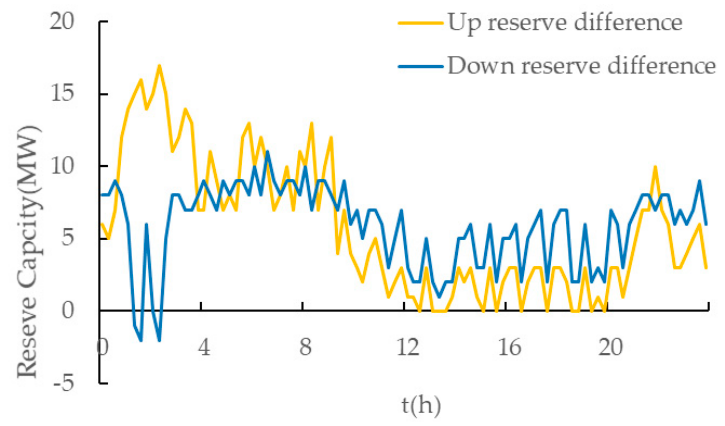
Figure 6. R DW – R D curve.